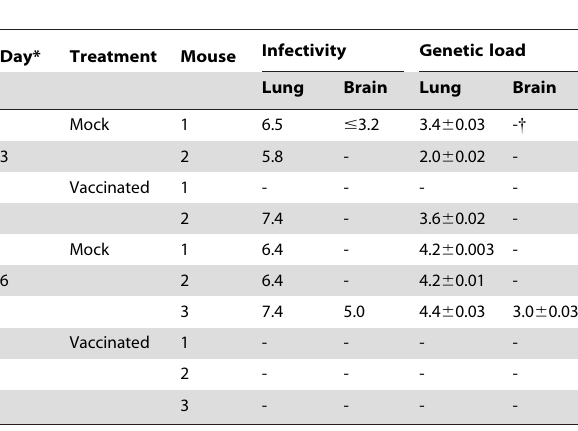
NOTE. Viral infectivity and relative viral genetic loads are expressed as log 10 TCID 50 /g and log 10 U per 20 ng of extracted RNA (geometric mean 6 s.d. of triplicate reactions), respectively, where 1 unit (1 U) of viral RNA is arbitrarily defined as the number of RNA molecules which, when reverse transcribed and subjected to real-time PCR, produced a C T value of 38. * Day post-challenge.